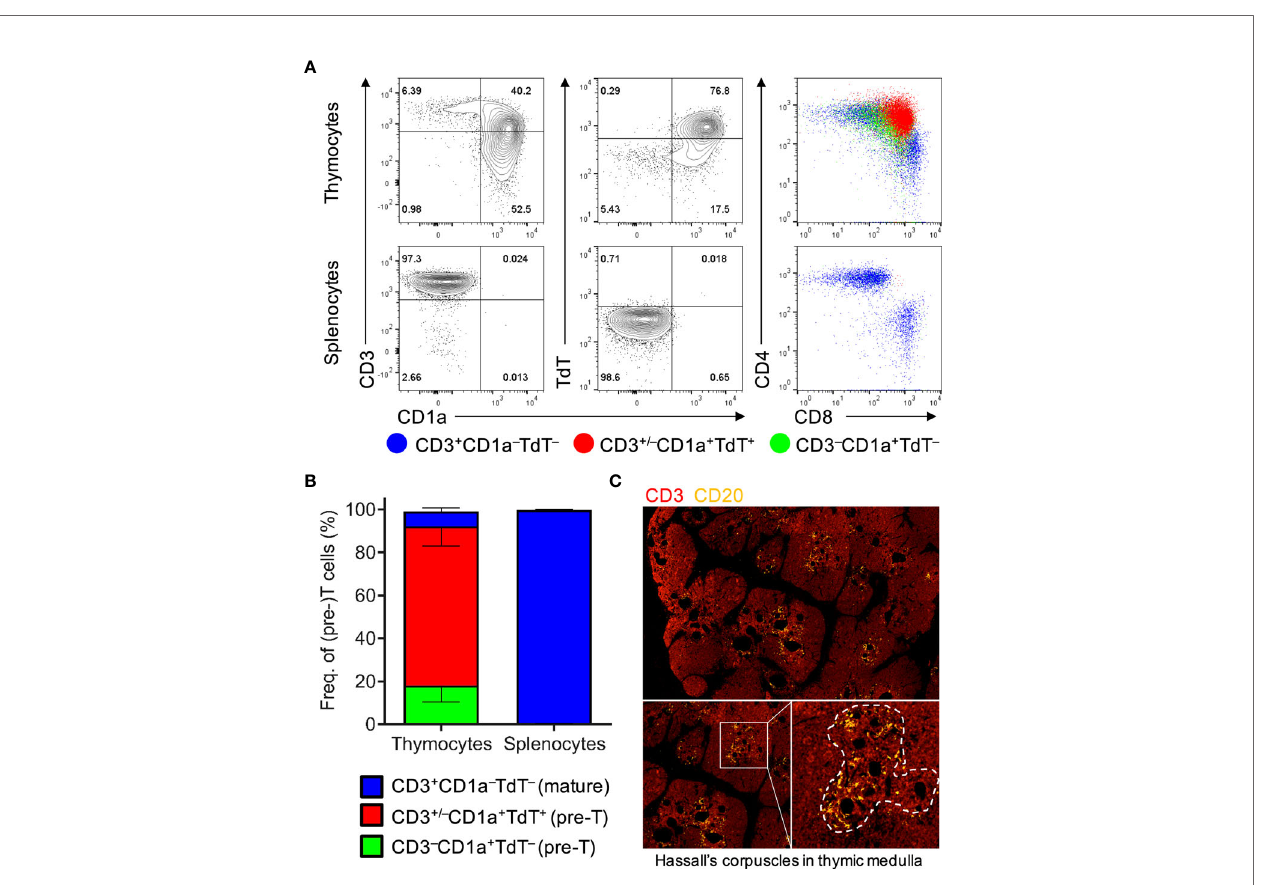
FIGURE 1 | Human thymic organoids in HuBLT mice sustain thymopoiesis. (A, B) Thymocytes and splenocytes were extracted mechanically from fresh human thymic organoids and mouse spleens from HuBLT mice. Representative fl ow cytometry plots (in A ) and aggregate data (in B ; n = 6 mice from 2 distinct human tissue donors) show the frequencies of precursor T cells (CD3 – CD1a + TdT – ; green), precursor T cells undergoing TCR recombination (CD3 +/ – CD1a + TdT + ; red), and mature T cells (CD3 + CD1a – TdT – ; blue). For (B) , stacked bars with error bars depict mean and standard deviation. (C) A representative immuno fl uorescence histology image of a thymic organoid stained with anti-CD3 (red) and anti-CD20 (orange) at three different magni fi cations is demonstrated; Hassall ’ s corpuscles in the thymic medulla containing thymic B cells is outlined with a white dotted